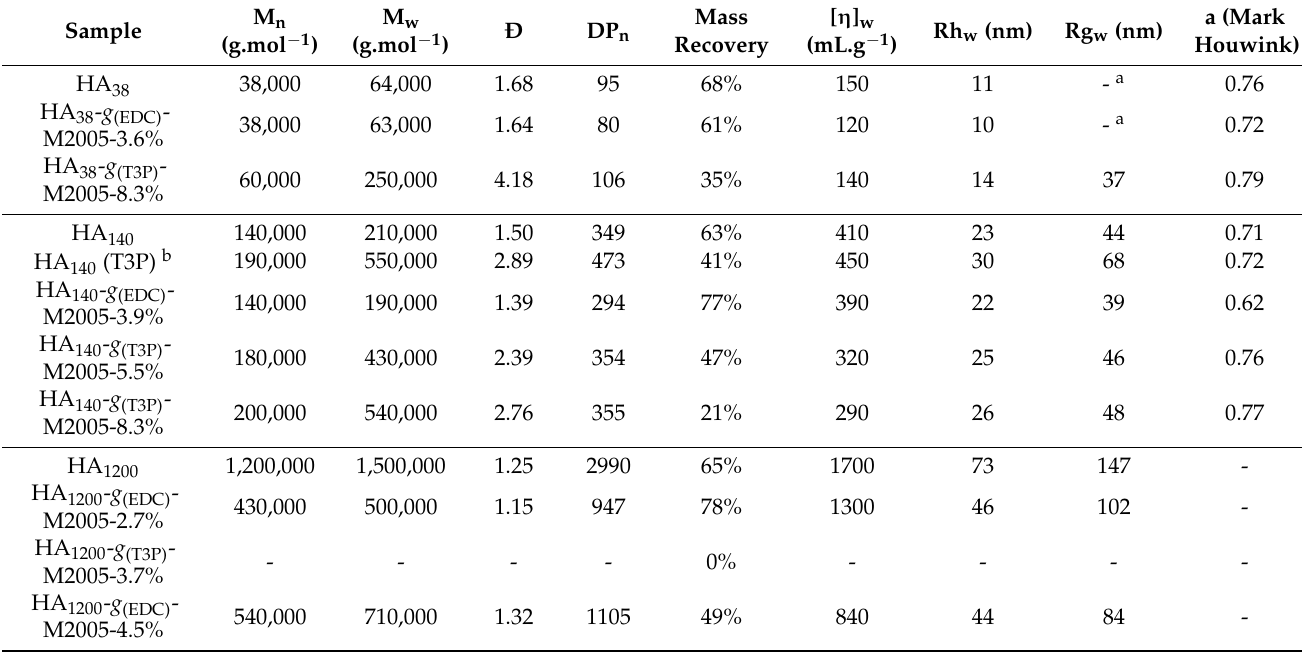
MHS coefficient (a) has been determined by integrating the most linear part of bilogarithmic representation of intrinsic viscosity vs. molar mass; SEC/MALS/VD/DRI data accuracy: M n ± 9%; M w ± 6%; Ð ± 10%; [ η ] w ± 0.5%; Rh w ± 2%; Rg w ± 6%; a Out of the range of the MALS detector (isotropic diffusion for lower masses fractions); b Sample reacted with T3P ®